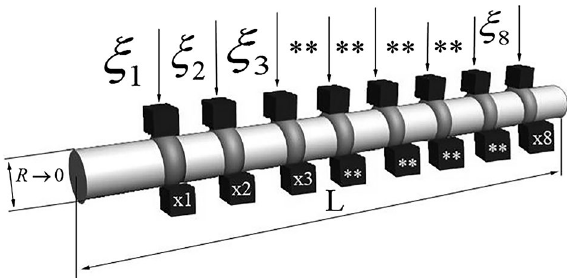
Figure 1. Schematic representation of the